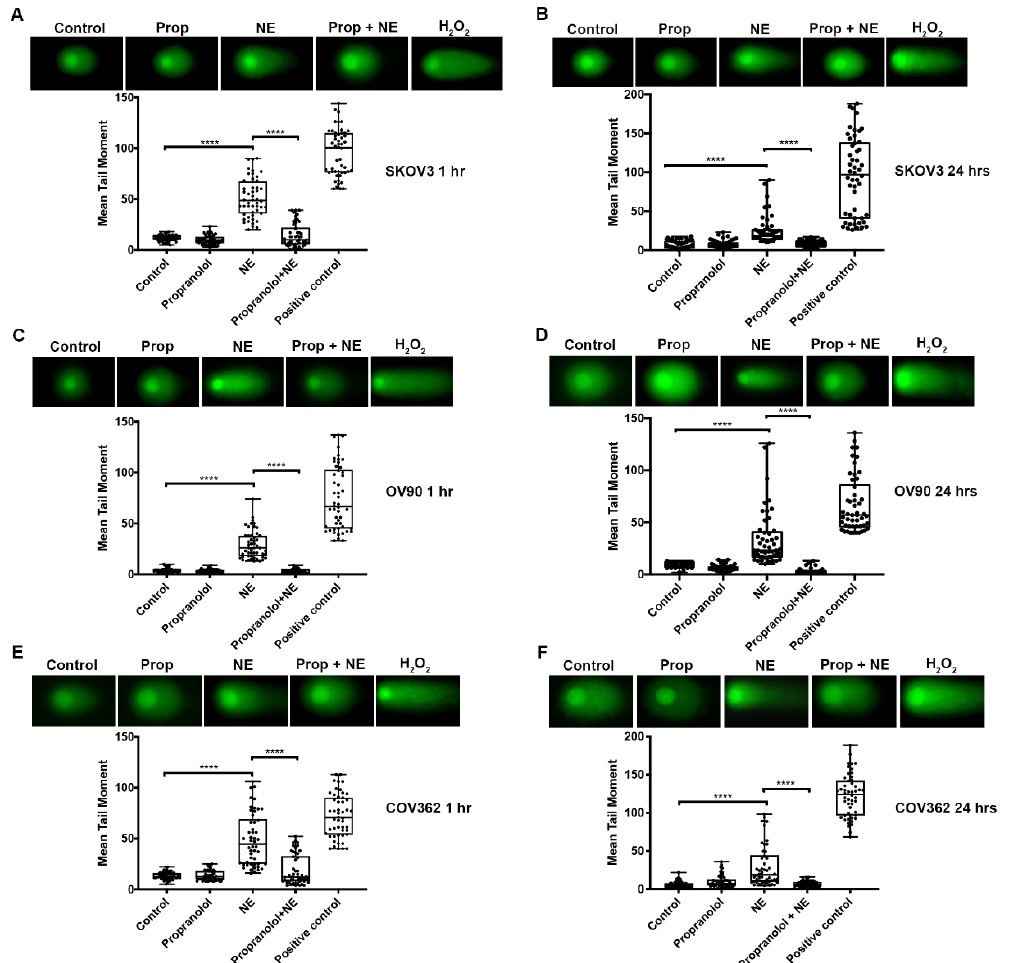
Figure 2. Propranolol abrogates NE-induced DNA double strand breaks. Neutral comet assays shown after exposure of SKOV3 ( A , B ), OV90 ( C , D ), or COV362 ( E , F ) cells to propranolol followed by NE (10 µ M) for 1 h or 24 h. DNA double-strand breaks were measured using the mean tail moment. Fifty (50) comets were evaluated for each treatment. Data presented is representative of three independent experiments performed in duplicate. Statistical analysis was performed using one-way ANOVA with Dunn’s multiple comparison correction. (**** p < 0.0001).